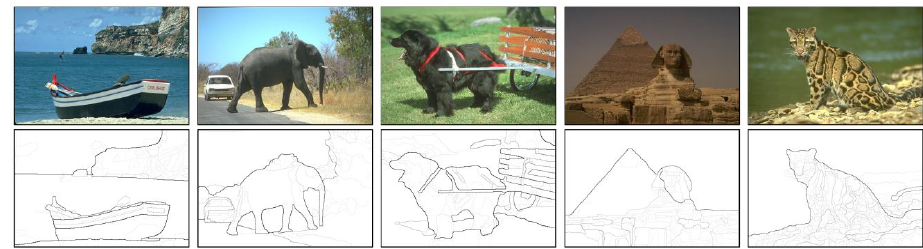
Figure 5. Example of images and corresponding ground truth from BSDS